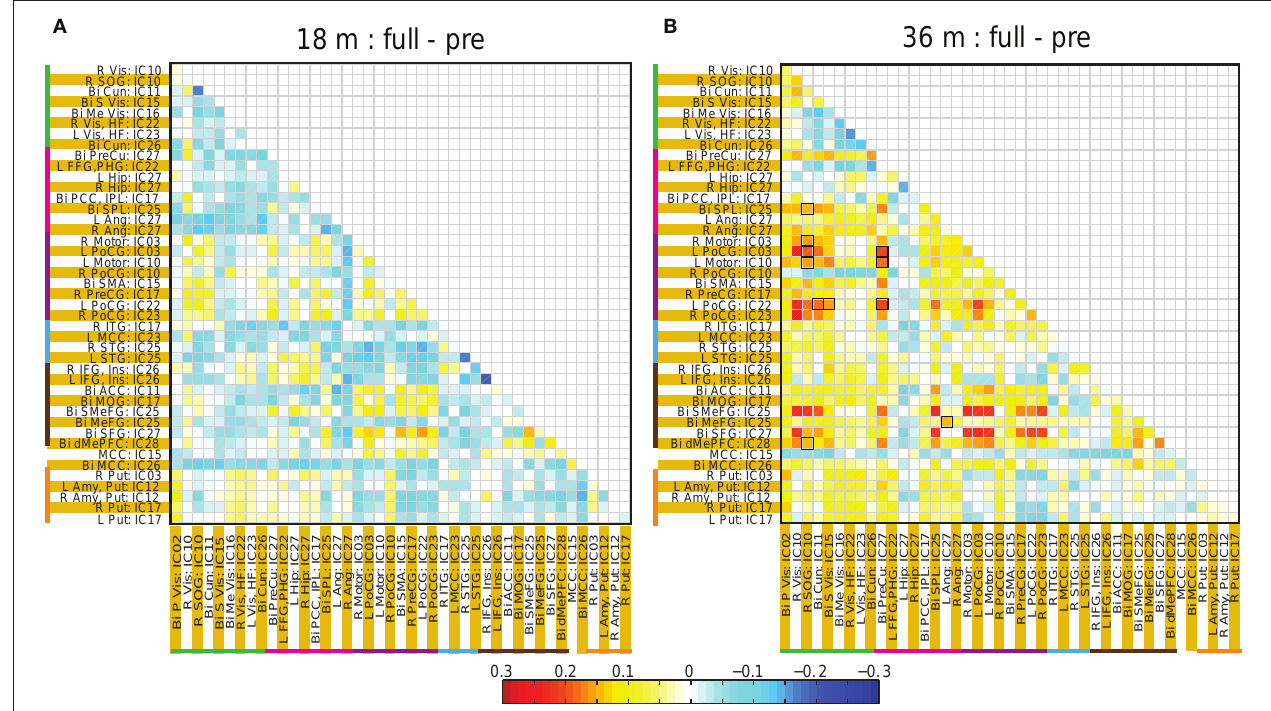
Figure 8 | Difference in roi based group average correlation maps between full-term and pre-term children at age 18 months (A) and at 36 months (B). The cells enclosed in black square represent, significant connectivity difference between groups based on a two sample t -test assuming unequal variance and surviving and FDR corrected threshold of p < 0.05.